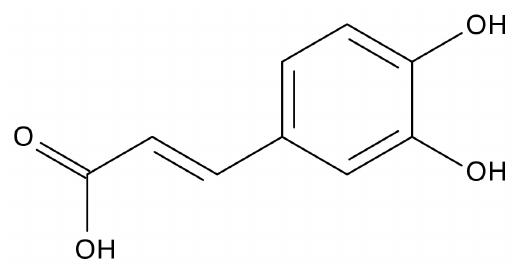
Figure 1. The chemical structure of caffeic acid.